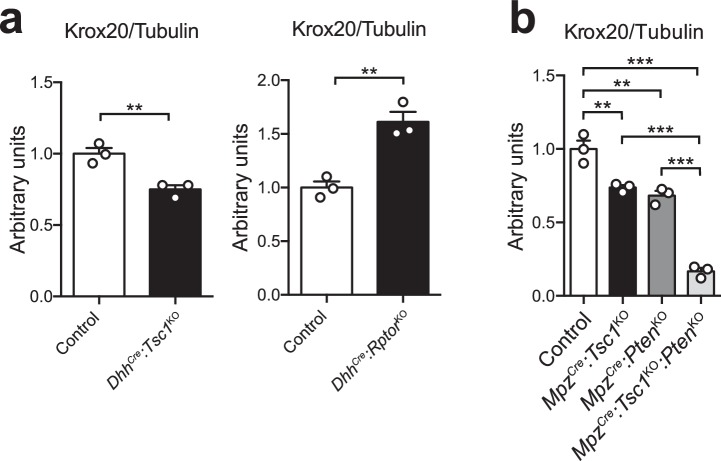
Quantification of western blots.Bar height: mean; error bars: s.e.m. (a) Quantification referring to Figure 3e. Control average is set to 1 (n = 3 mice/genotype, including the biological replicates representatively shown in Figure 3e, two-tailed unpaired Student’s t-test, t(4)control vs TSC1KO = 5.054, t(4)control vs RaptorKO = 5.637, pcontrol vs TSC1KO = 0.0072, pcontrol vs RaptorKO = 0.0049). (b) Quantification referring to Figure 3f. Control average is set to 1 (n = 3 mice/genotype, including the biological replicates representatively shown in Figure 3f, one-way ANOVA with Tukey’s multiple comparisons test, F(3,8) = 95.35, p<0.0001; pcontrol vs TSC1KO = 0.0036, pcontrol vs PTENKO = 0.0011, pcontrol vs doubleKO <0.0001, pTSC1KO vs doubleKO <0.0001, pPTENKO vs doubleKO <0.0001). *p<0.05, **p<0.01, ***p<0.001.